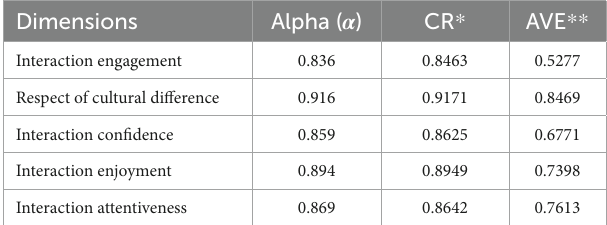
TABLE 2 Reliability and validity